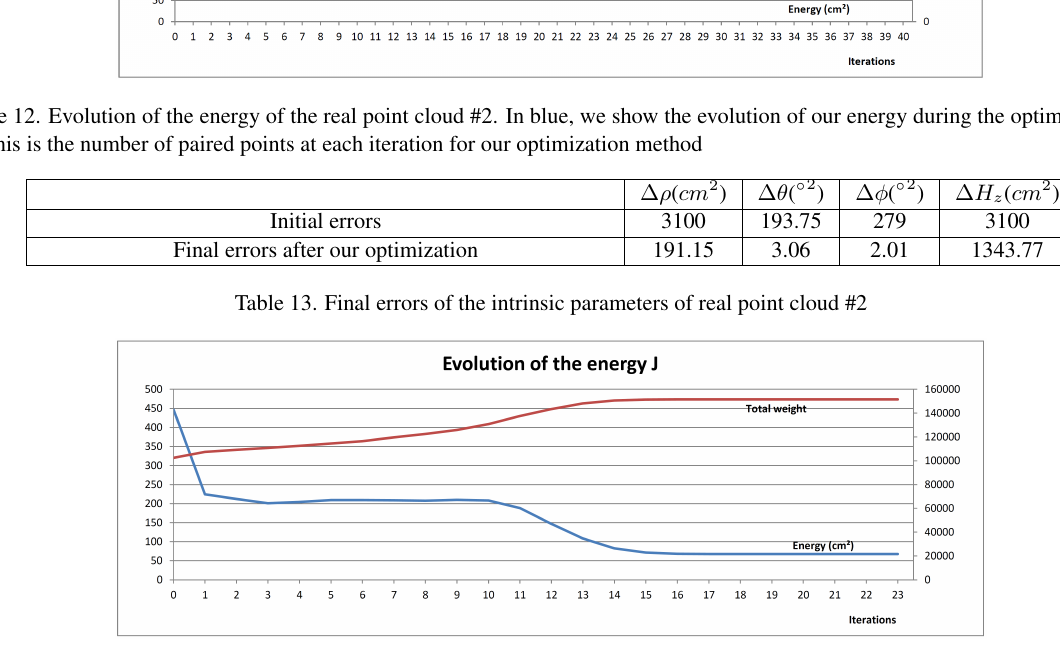
Figure 14. Evolution of the energy of the real point cloud #3. In blue, we show the evolution of our energy during the optimization; in red, this is the number of paired points at each iteration for our optimization method